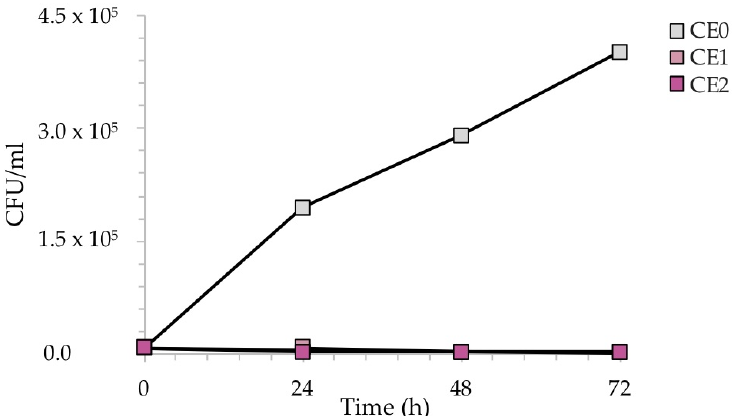
Figure 10. CFU/mL recovered after the exposure of the contaminated silver-treated enameled surfaces to C. albicans . The results are representative of three independent determinations.